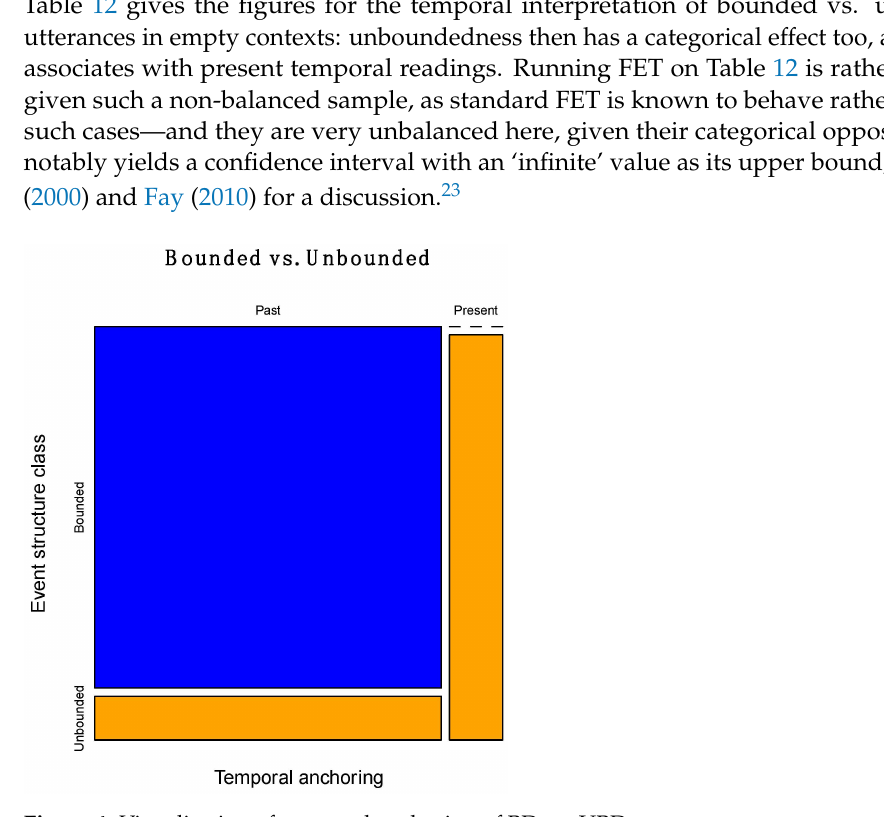
Figure 4. Vizualisation of temporal anchoring of BD vs. UBD utterances. Table 12. Temporal anchoring of BD vs. UBD utterances in an empty